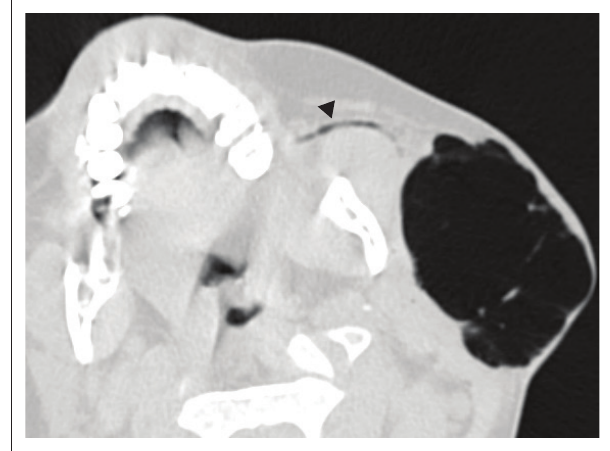
FIGURE 3: Magnified axial non-contrasted computed tomography demonstrating gas in the mildly distended left Stenson’s (parotid) duct (black arrowhead).